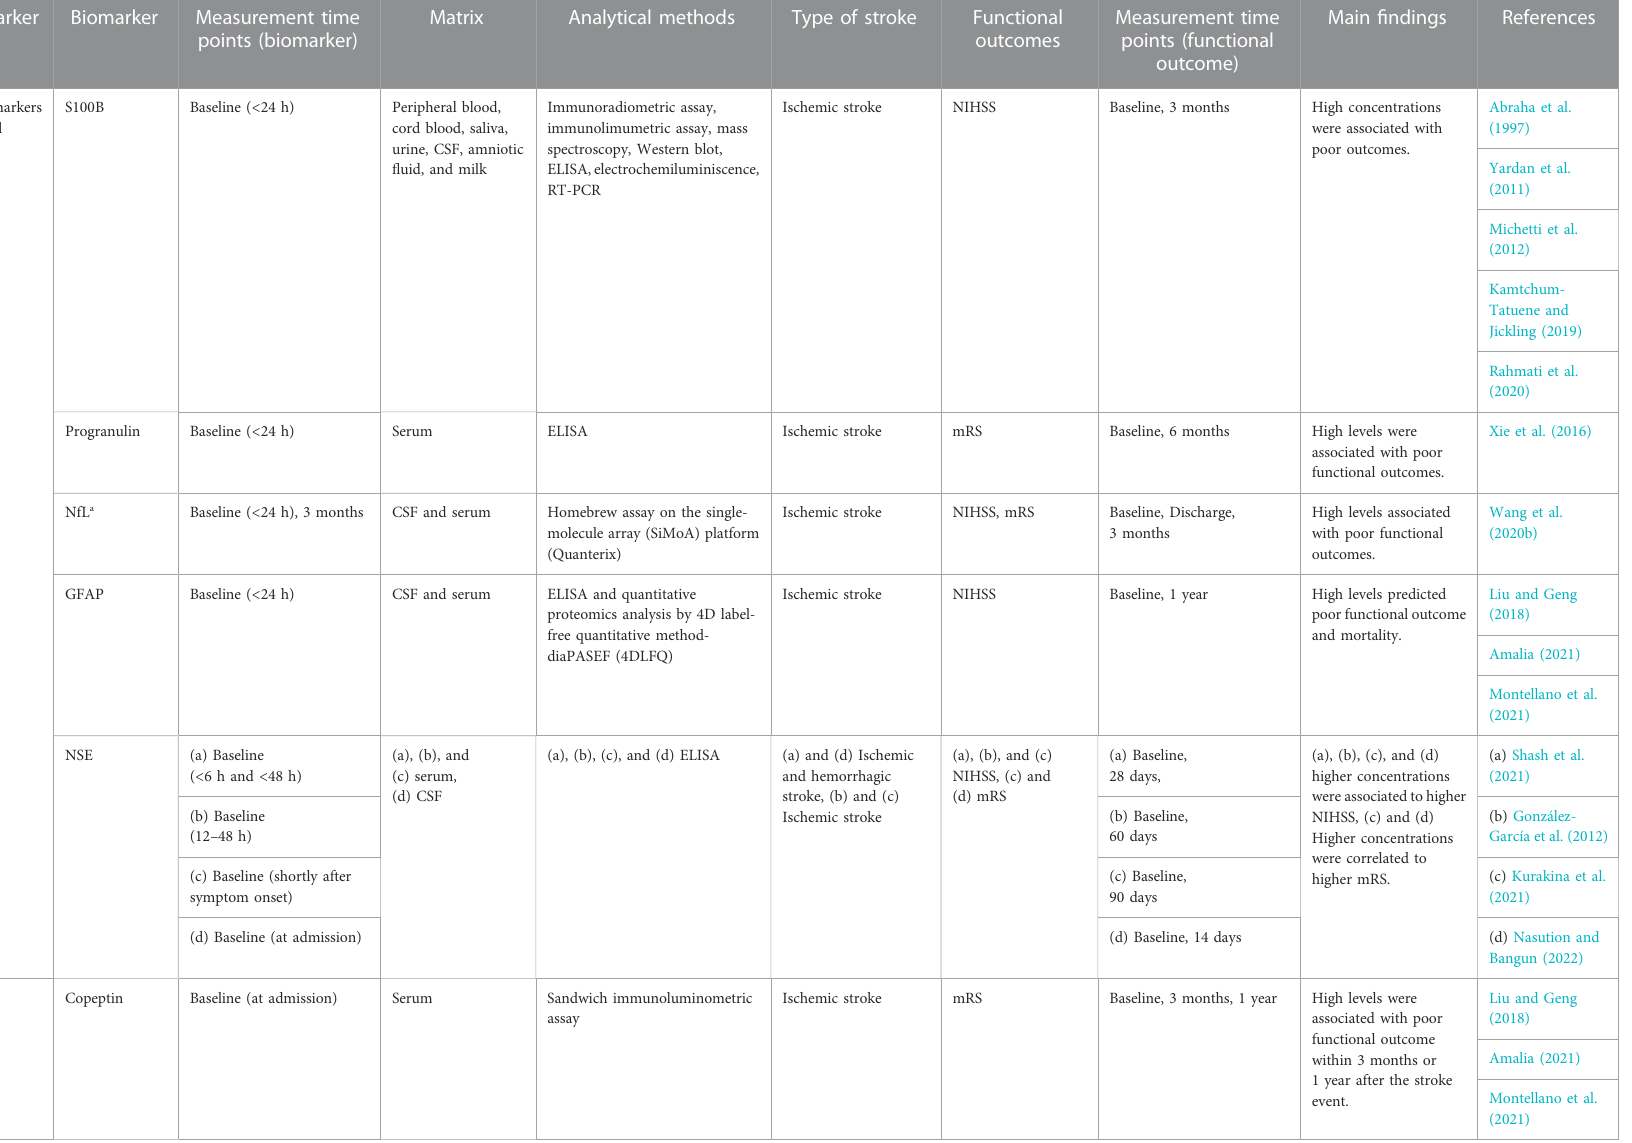
TABLE 2 Molecular, genetic and epigenetic biomarkers for stroke